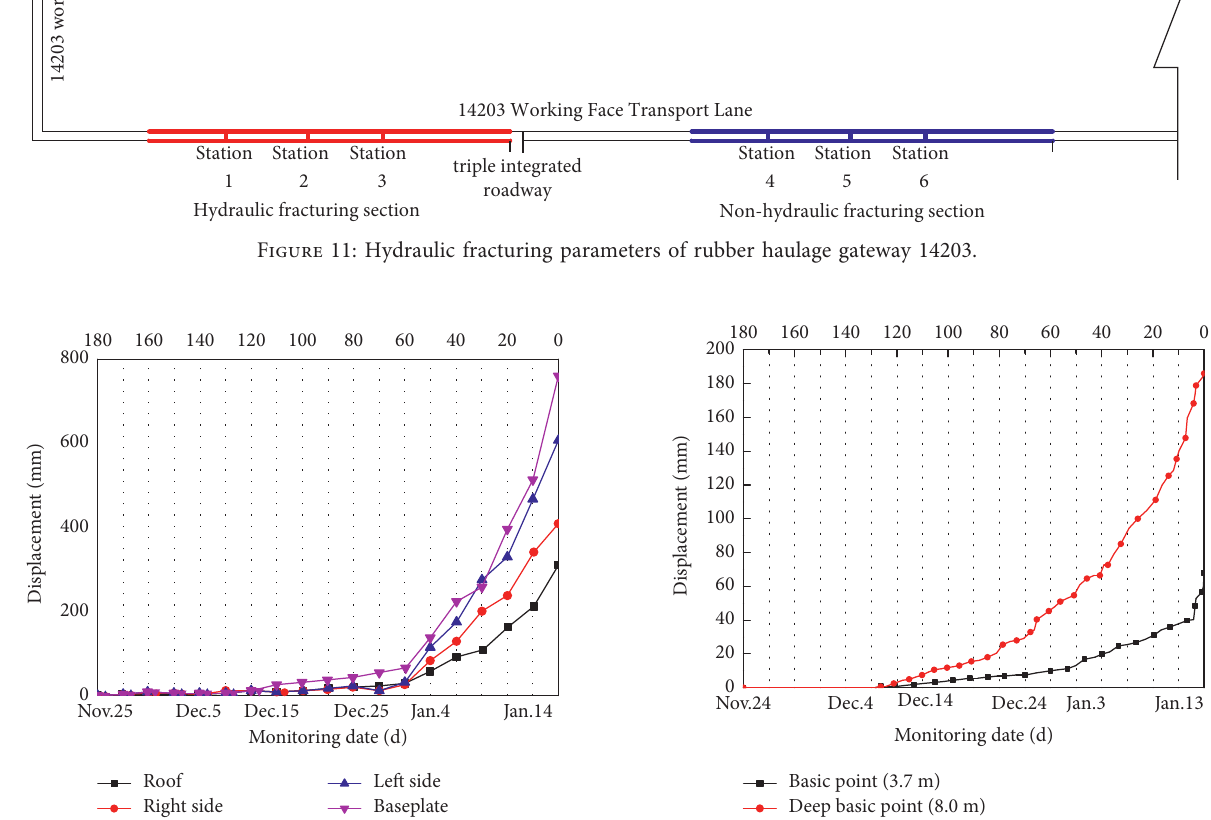
Figure 14: Nonhydraulic fracturing section: roof separation curve of 5# station.